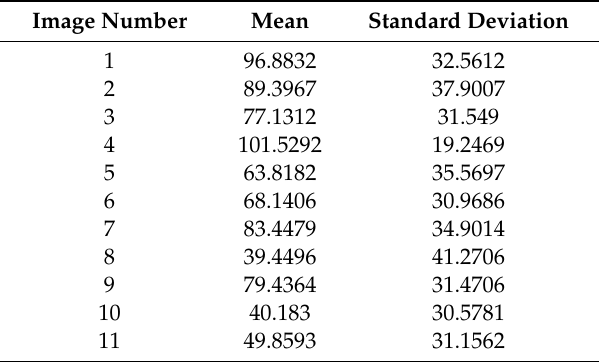
Table 2. Mean and standard deviation of test